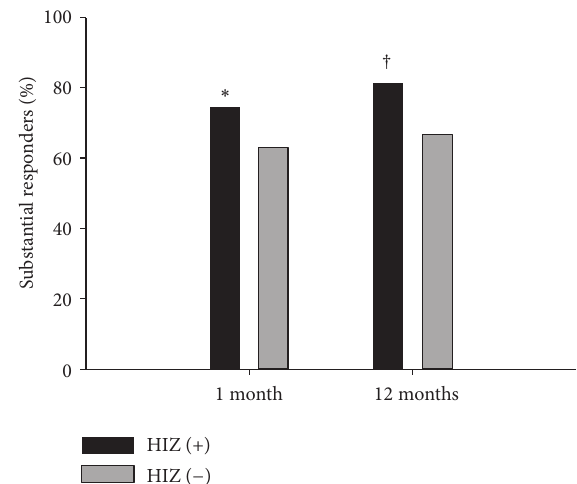
Figure 4: The proportion of substantial responders in the high- intensity zone (HIZ) positive patients and the HIZ negative patients; ∗ 𝑃 = 0.028 , † 𝑃 = 0.002 .